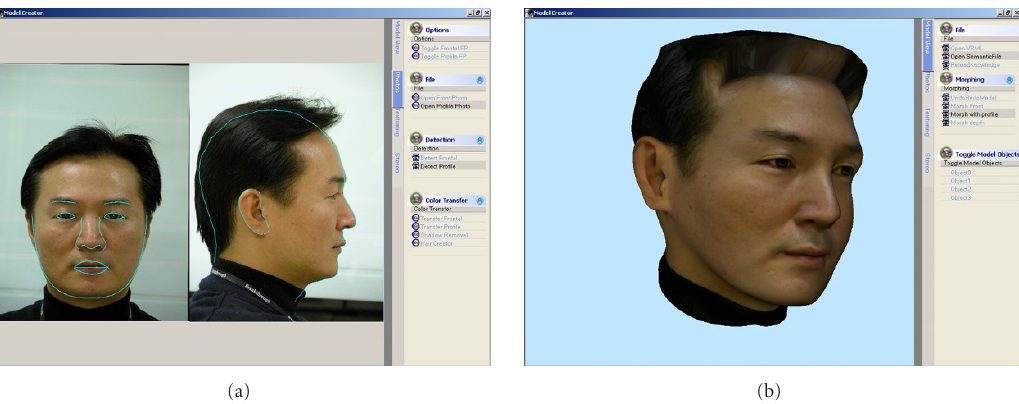
Figure 20: Developed face modeling system. (a) Feature extraction module is working. (b) The generated 3D model is being